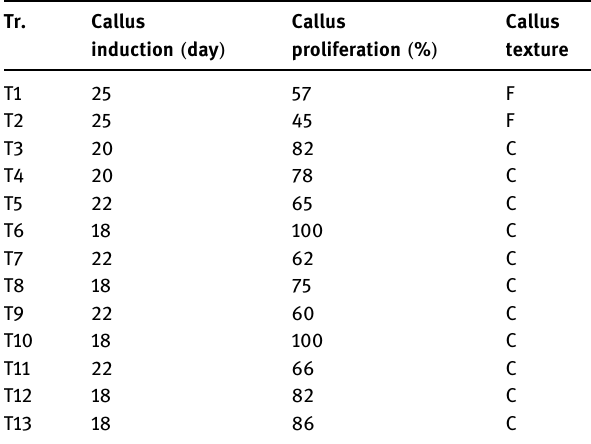
Table 2: Impact of di ff erent ratios of Ag NPs and Cu NPs alone or in combination with TDZ on callus proliferation and texture in A. absinthium